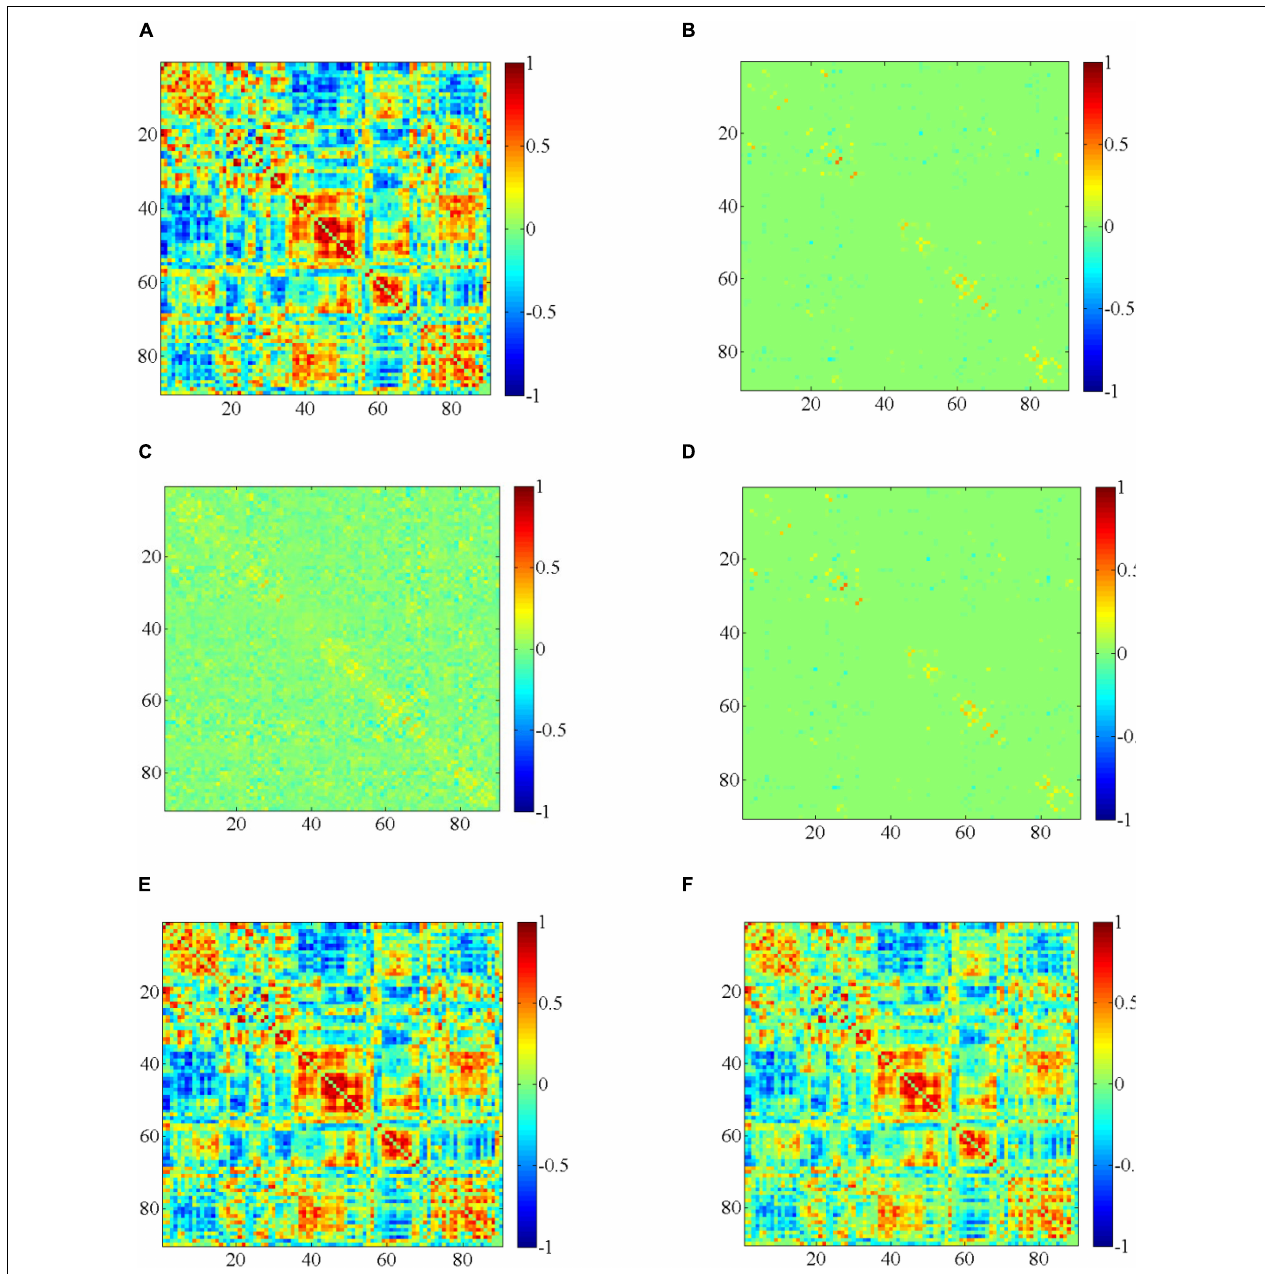
FIGURE 3 | Visualization results of constructing the BFN in the same time window by different methods. (A) PC, (B) SR, (C) MR, (D) SMR, (E) HMR, and (F) SHMR.